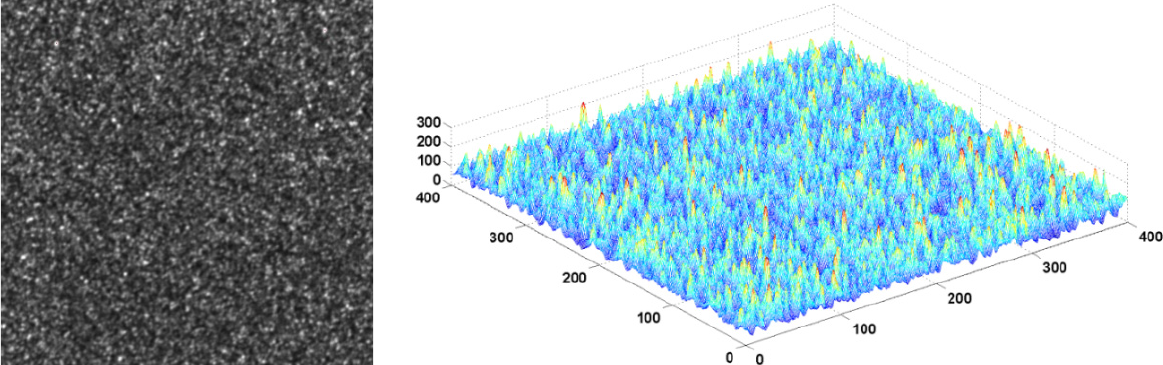
Figure 3. A laser illumination image is recorded by a CCD camera with the speckle contrast of 46.2% (left) and 3D intensity distribution is analyzed by MATLAB (right).